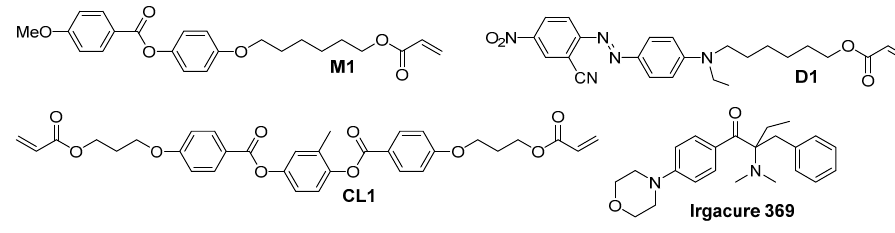
Figure 1. Monomer structures.